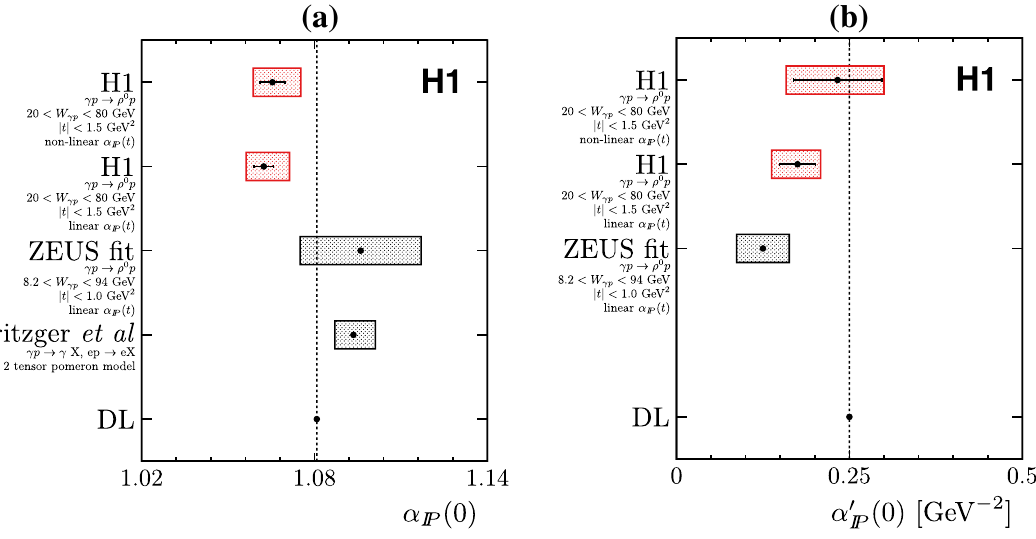
Fig. 20 Comparison of the soft pomeron intercept ( a ) and slope ( b ) according to Donnachie and Landshoff (DL) [91,92] with measure- ments of the leading trajectory in ρ 0 meson photoproduction in the present paper and from an analysis of previous data [13], as well as with a measurement of the intercept from inclusive DIS and photo-